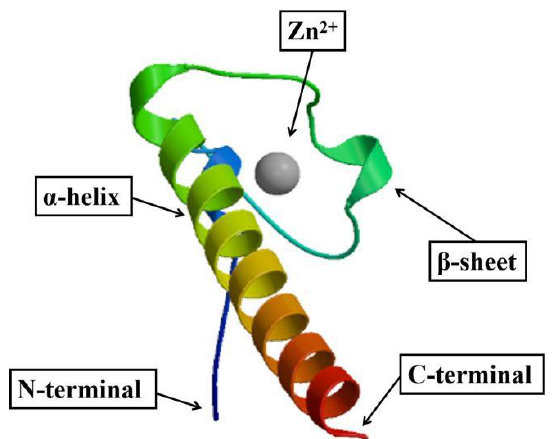
Figure 2. Three-dimensional protein structure of PmDsx. The protein of PmDsx is composed of zinc finger structures, containing α -helix, anti-parallel β -sheets, and Zn 2+ finger structures, containing α -helix, anti- parallel β -sheets, and Zn 2+ .